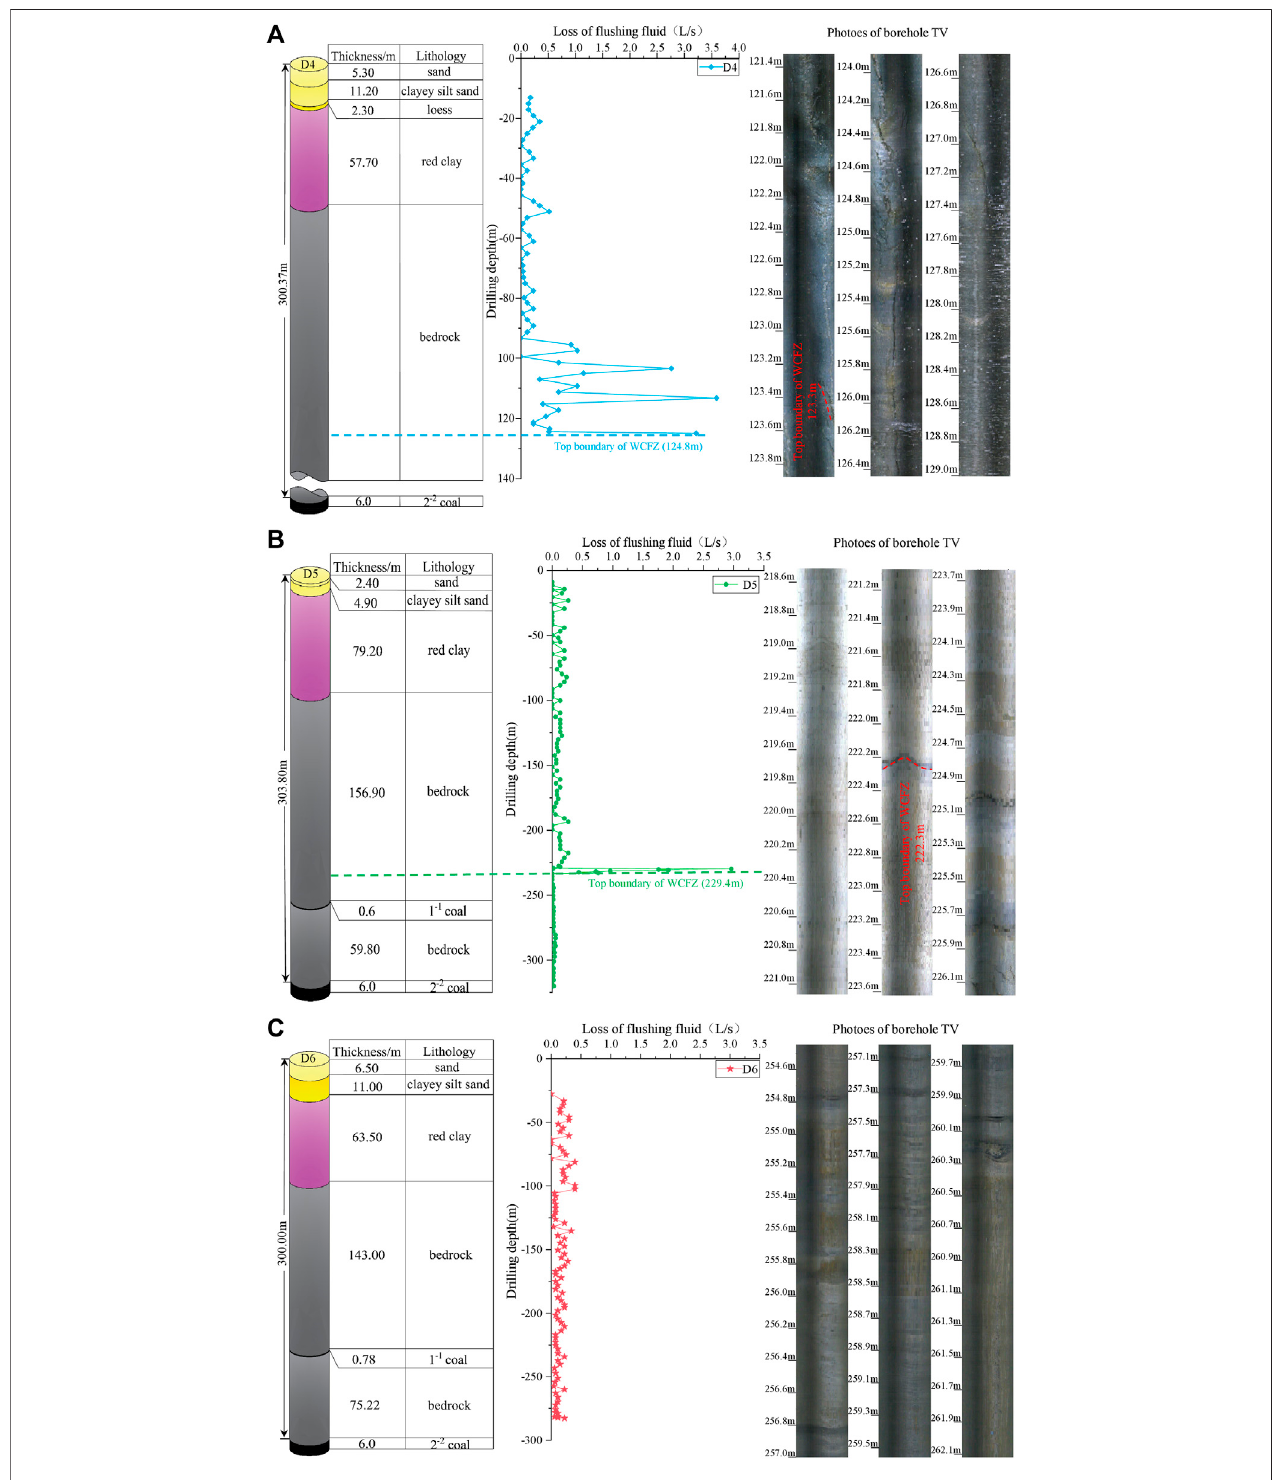
FIGURE 5 | Hole fl ushing fl uid leakage and borehole TV results: (A) D4, (B) D5, and (C) D6.